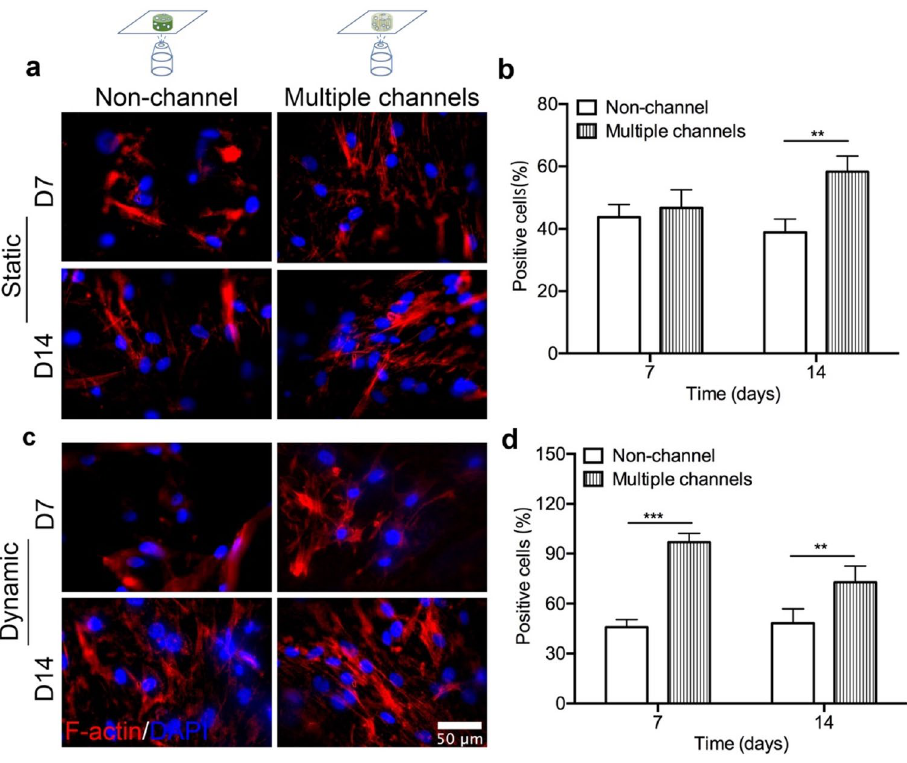
Figure 4. Mechanotransduction protein expression: stained scaffolds were placed on a glass cover slide for imaging. F-actin staining of hBMSC cells on the scaffolds under the static condition ( a ) and its F-actin expression percentage quantification ( b ), and under the dynamic condition ( c ) and its F-actin expression percentage quantification ( d ) at 7 and 14 days. F-actin expression percentage was significantly higher, and the positive signal was stronger in the multiple channeled scaffolds (n = 3, * p < 0.05, ** p < 0.01, *** p <